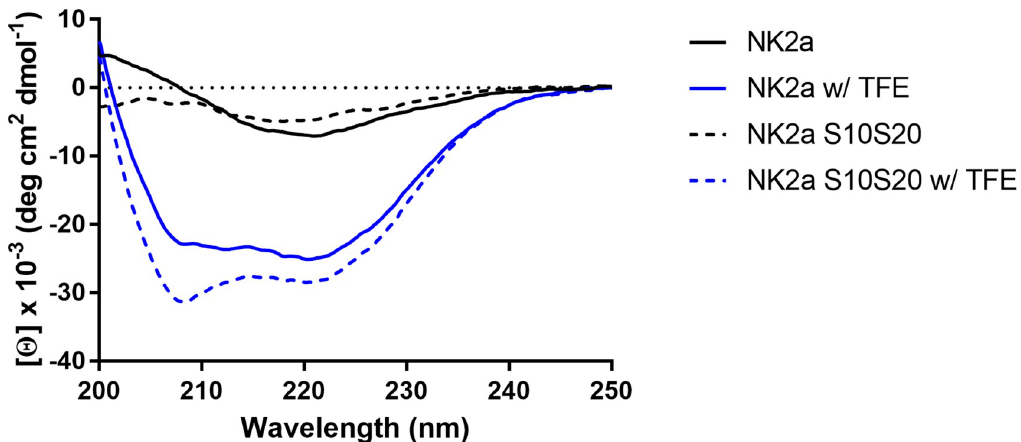
Fig 1. The original bNK2A-C10C20 and an analog bNK2A-S10S20 peptides showed similar α -helical confirmations. Circular dichroism (CD) spectral analysis of the peptides (20 μ M final concentrations) was performed at room temperature using Jasco J-850 CD spectrophotometer in the presence of or absence of 50% TFE. Measurements were taken every 0.1 nm from 200 nm to 250 nm. Shown graphs are the means of six accumulations after baseline correction for each peptide.